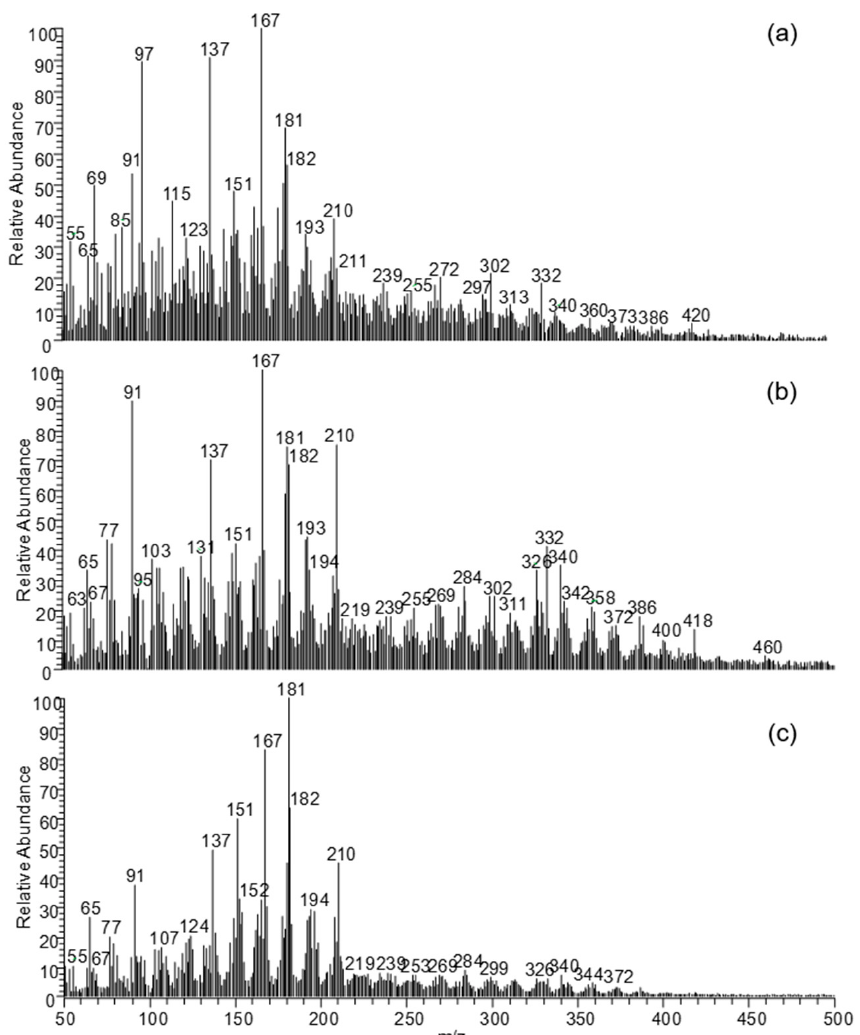
Figure 1. DE-MS mass spectra of a reference sound oak sample ( a ), samples of archaeological oak wood from Oak 6 from Biskupin site ( b ) and La Marmotta (2212-B) ( c ).